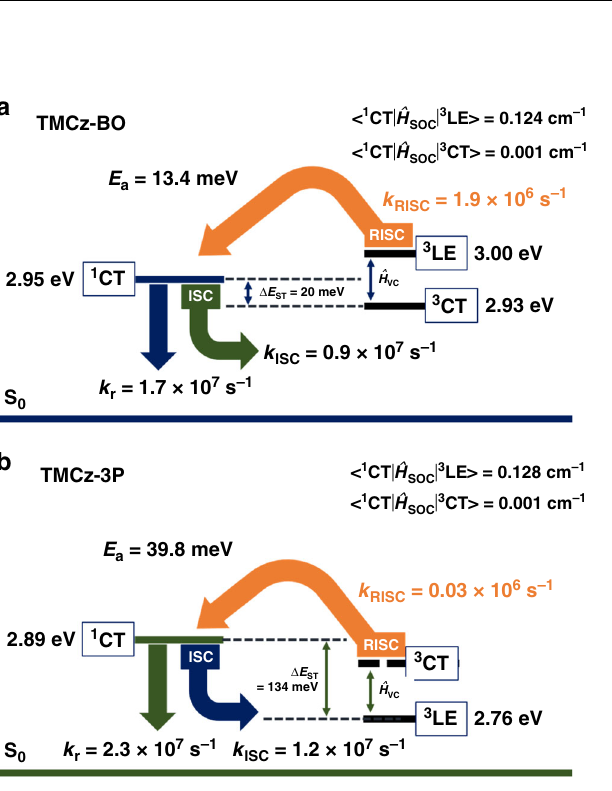
blue EL emission with peaks ( λ EL ) at 471 nm (deep blue) and 479 nm (blue) with corresponding CIE chromaticity coordinates of (0.14, 0.18) and (0.14, 0.26), respectively, which were consistent with their corresponding PL spectra. It is noteworthy that the